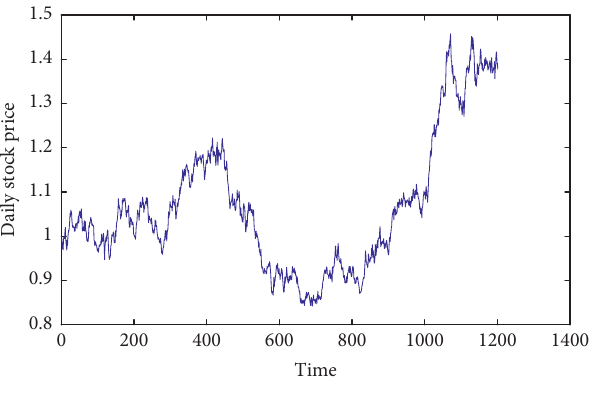
Figure 3: The simulated stock price.